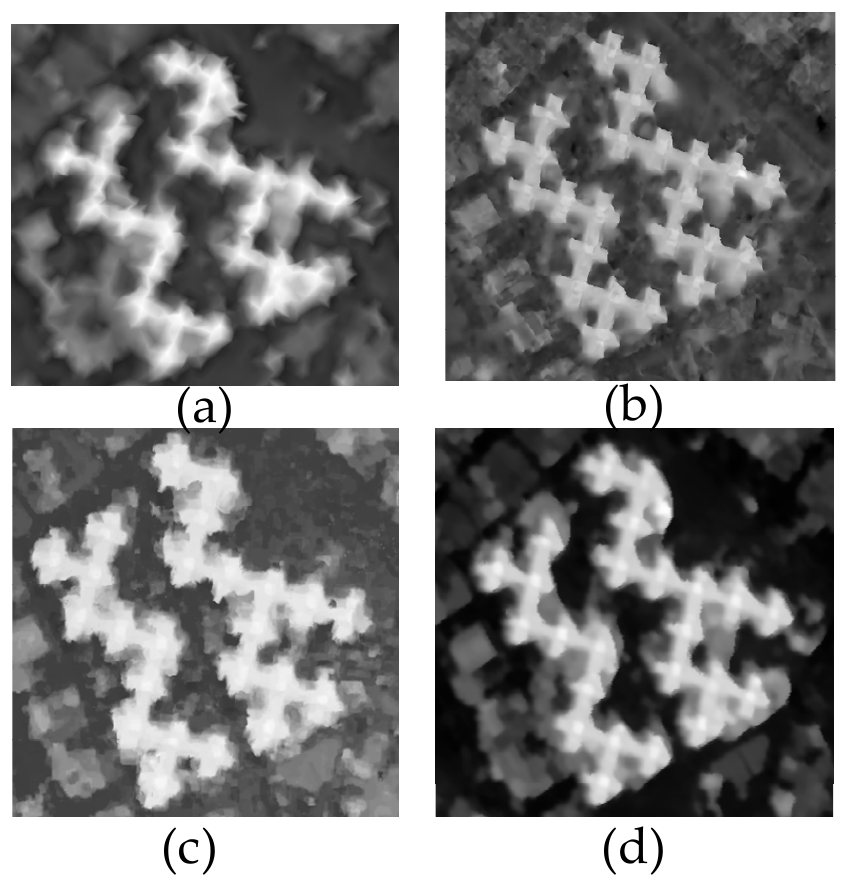
Figure 13. Results for test site 1 with different methods: ( a ) input, ( b ) refinement, ( c ) SGM, ( d )